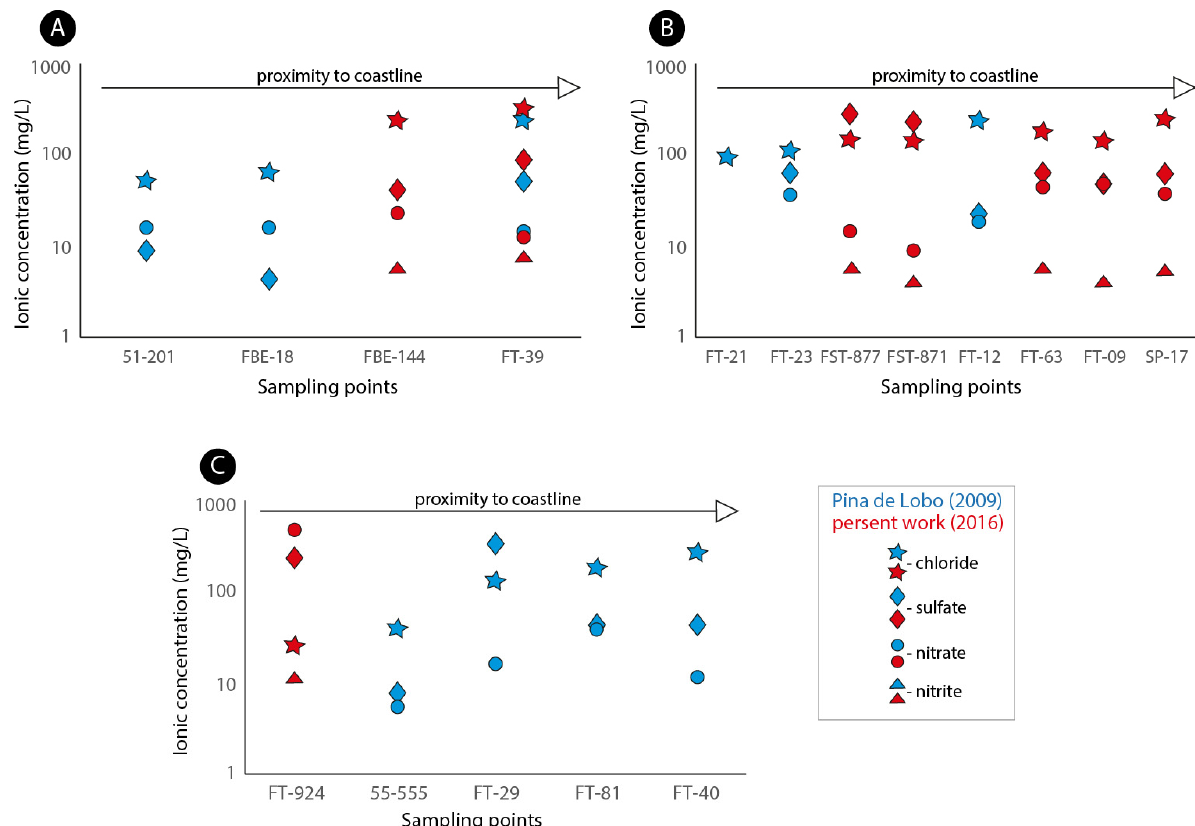
Figure 13. Pattern of temporal and spatial evolution of anion indicators of water quality in the S. Miguel ( A ), Ribeira Seca ( B ) and S. Domingos ( C ) river sub-basins. The graphs show the evolution from upstream to downstream, i.e., from the valleys’ highest quotas to the lowest and widest sections of the valleys, which end at the eastern coastline.